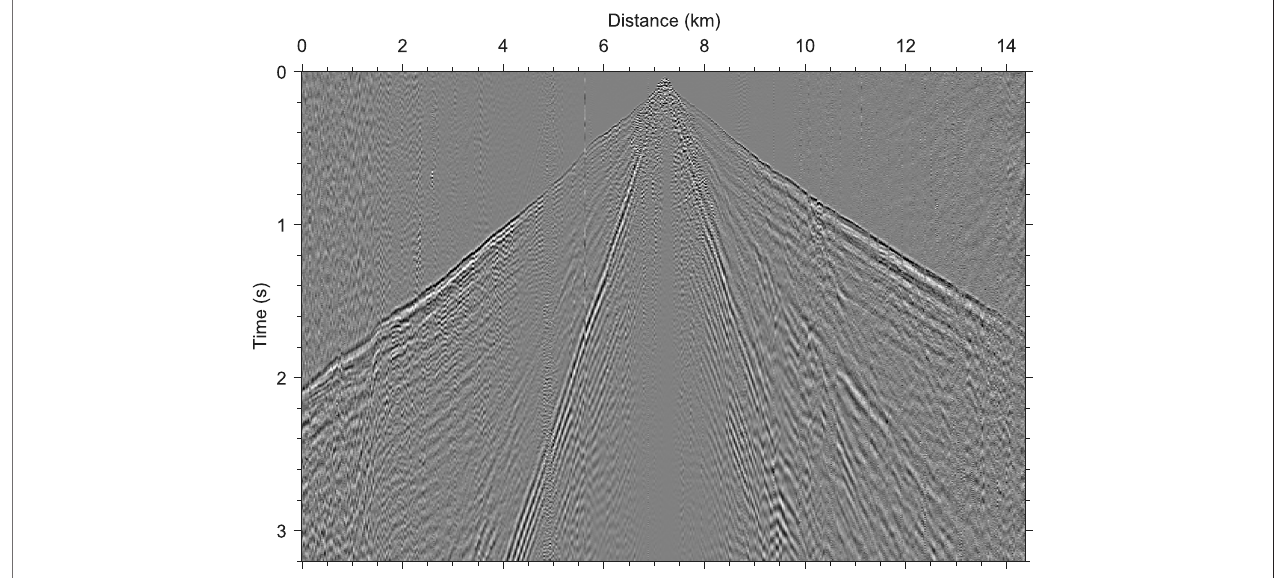
FIGURE2| Atypicalshotpro fi leacquiredfromthefoothillsaroundtheTarimBasin.Traceequalizationwasapplied. Re fl ectioneventsarebarelyseenwhilethe fi rst arrival is clear.